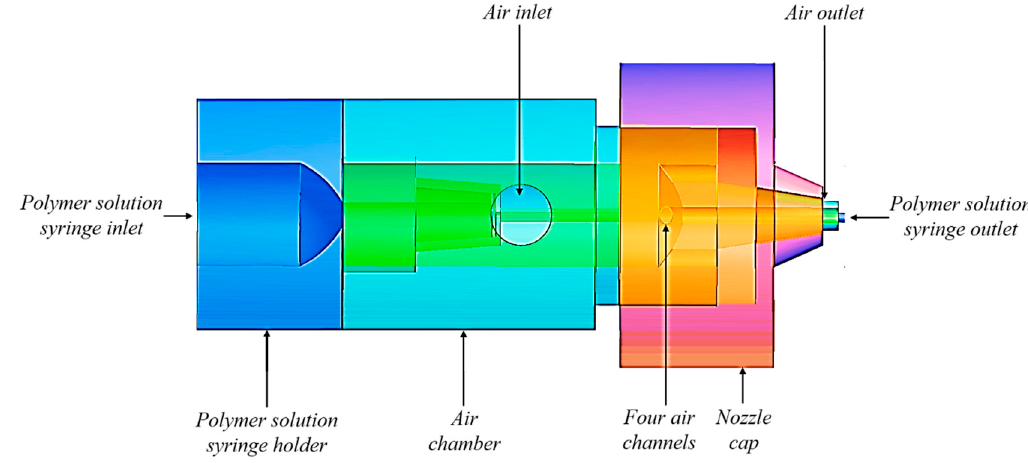
Figure 1. Di ff erent sections of solution blow spinning (SBS) nozzle. Polymers 2020 , 12 , x FOR PEER REVIEW Figure 1. Different sections of solution blow spinning (SBS) nozzle.